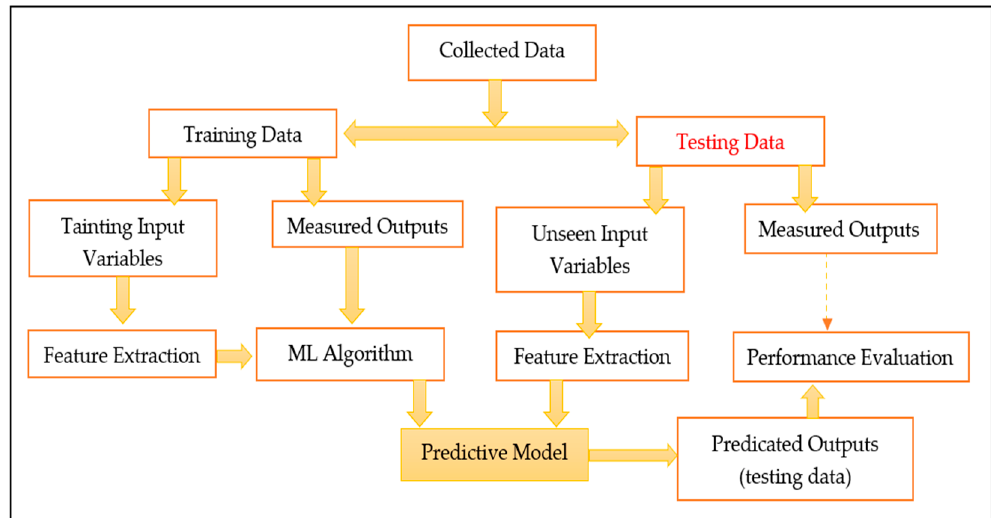
Figure 5. General supervised learning model.